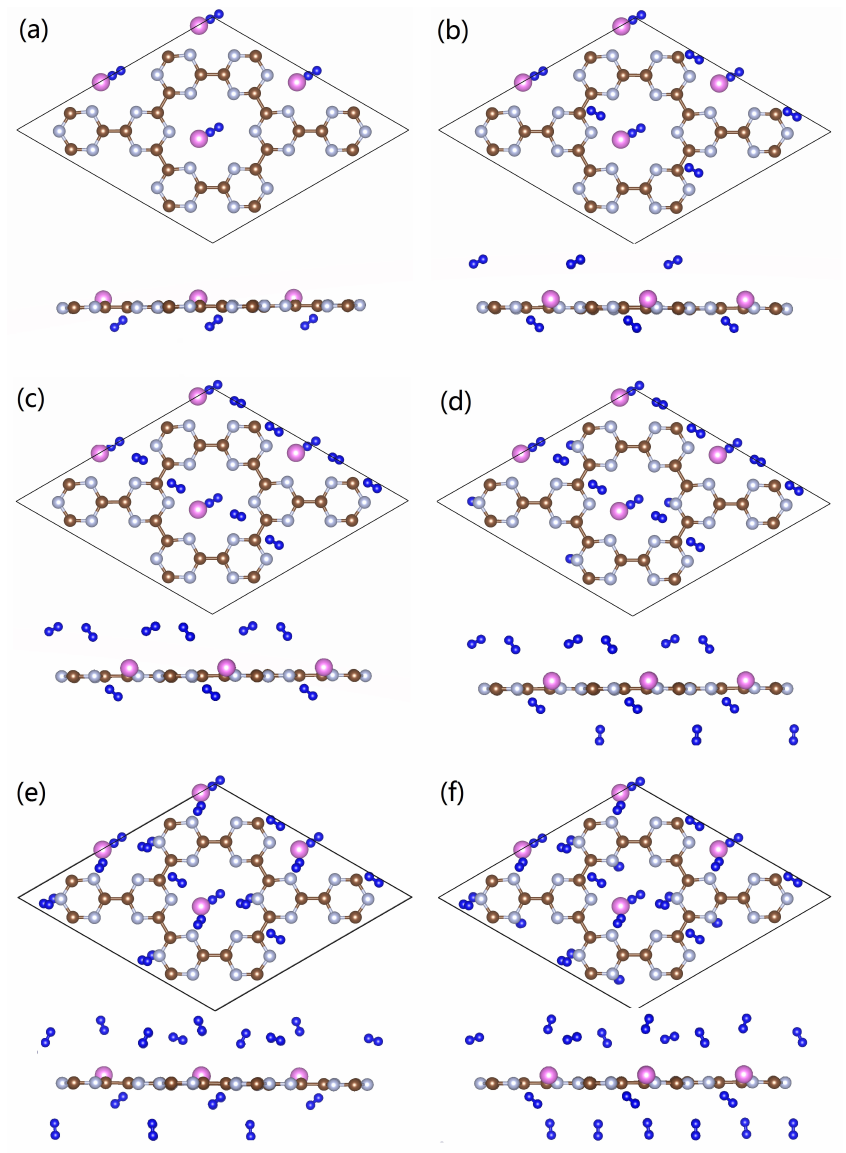
Figure 6. ( a – f ) The optimized configurations of the Al-doped g-CN with multiple adsorbed H 2 molecules (4–24).